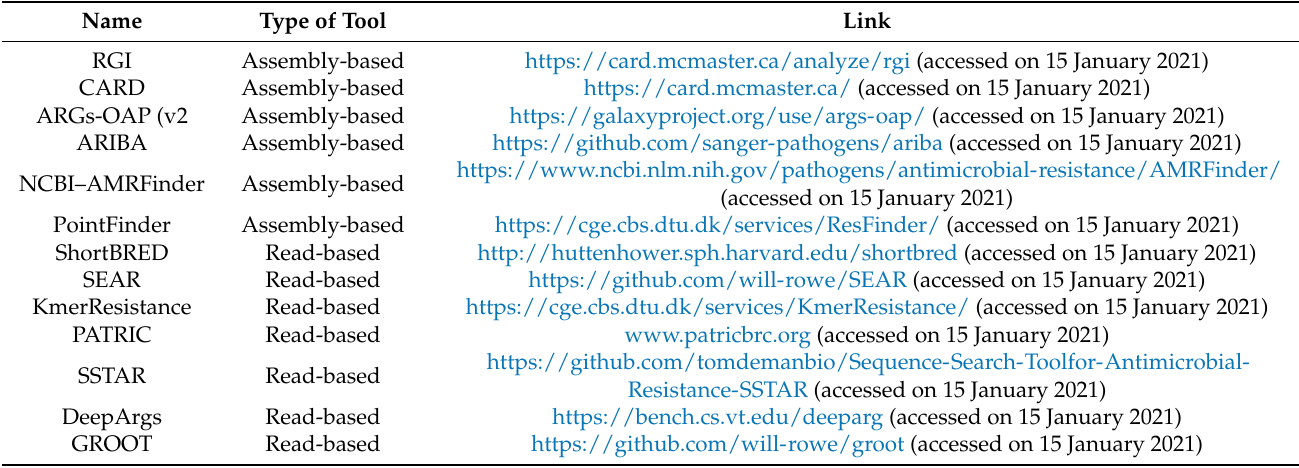
Table 1. Bioinformatic tools and databases for antimicrobial resistant gene (ARG) detection from whole genome sequencing (WGS) or whole metagenome sequencing (WMS)